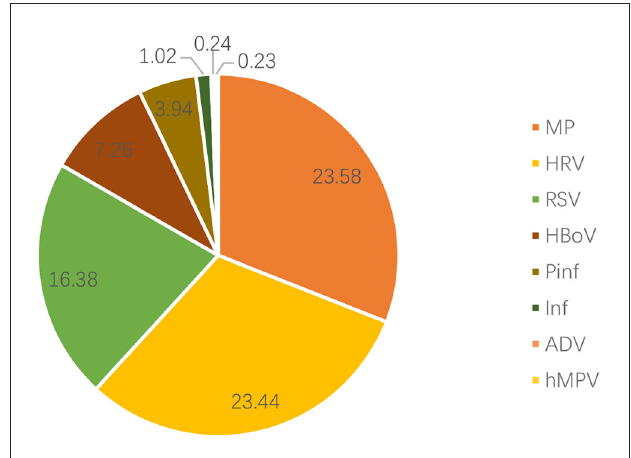
FIGURE1 Distribution of pathogens in the nasopharyngeal samples of children with bronchial asthma. RSV, respiratory syncytial virus; HRV, human rhinovirus; MP, Mycoplasma pneumoniae; HBoV, human bocavirus; Pinf, parainfluenza virus; Inf, influenza virus; ADV, adenovirus; hMPV, human